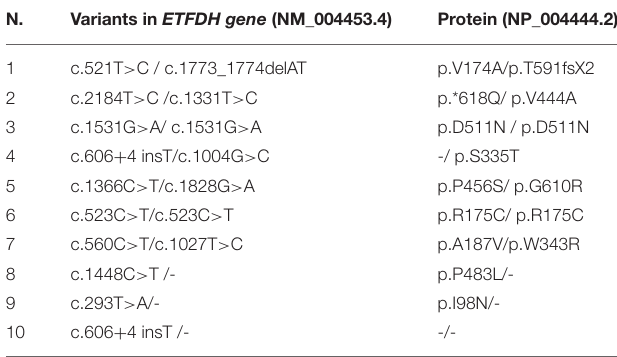
TABLE 2 | Summary of the ETFDH gene variants identified in 10 patients.